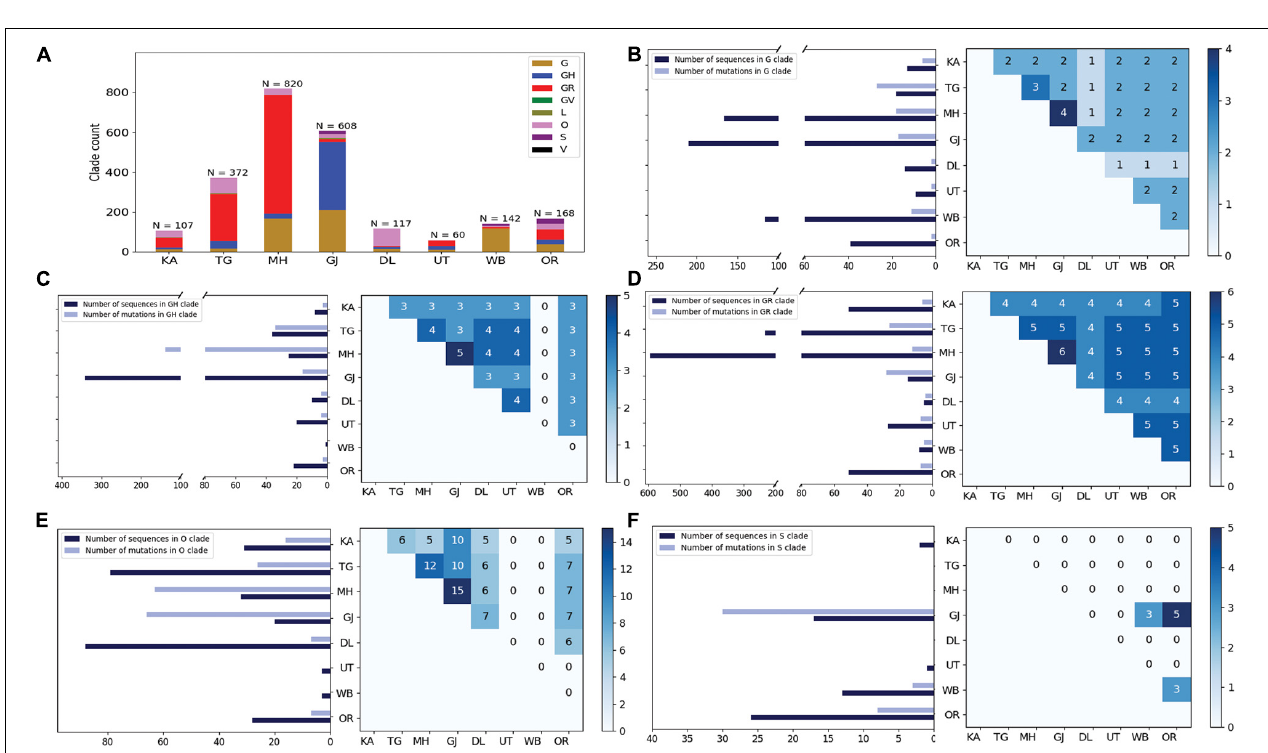
FIGURE 1 | Distribution and dynamics of SARS-CoV-2 clades in India for three different time spans in the year 2020. Distribution of GISAID (A) and Nextstrain (B) clades across India for three different times spans: “Term1” (December 2019–March 2020), “Term2” (April 2020–July 2020), and “Term3” (August 2020–December 2020), respectively.